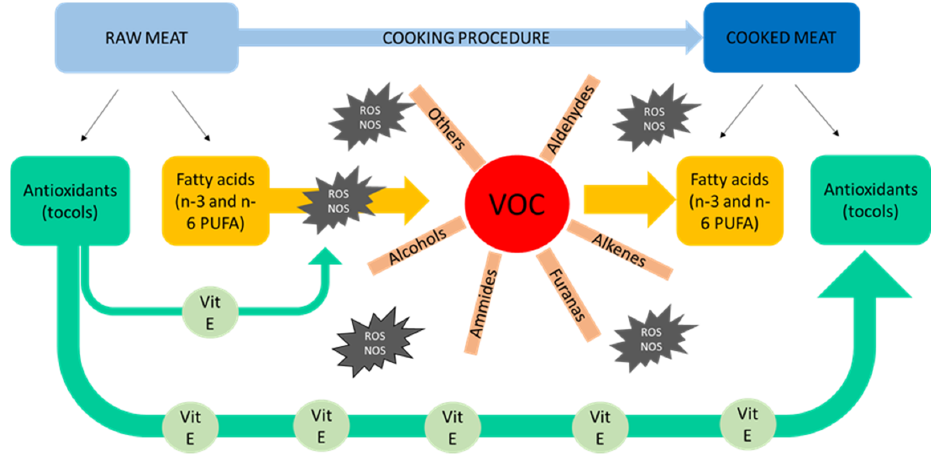
Figure 14. PUFA, VOC, and antioxidant dynamics in poultry meat during cooking process. NOS: reactive nitrogen species; PUFA: polyunsaturated fatty acid; ROS: reactive oxygen species; and VOC: volatile organic compound. Modified by [48].